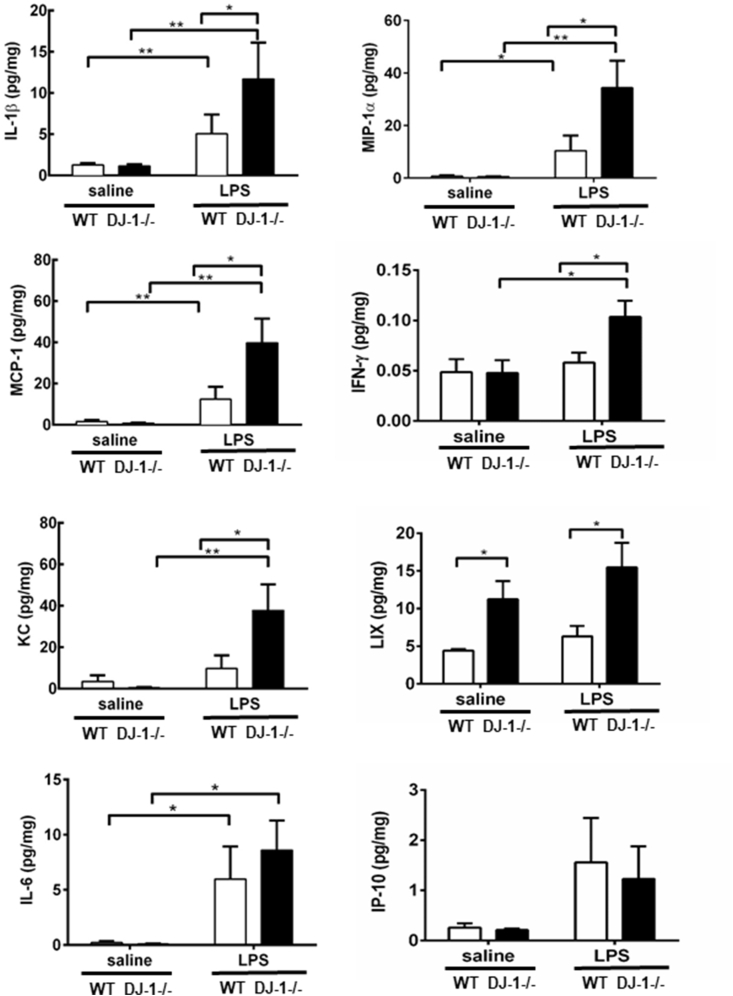
DJ-1 deficiency enhances lung inflammation following LPS instillation. Levels of inflammatory mediators in lung homogenates and serum from WT or DJ-1−/− mice 24 post LPS instillation. Mediators profiled: interleukin-1 beta (IL-1β), macrophage inflammatory protein 1 alpha (MIP-1α/CCL3), monocyte chemoattractant protein-1 (MCP-1/CCL2), interferon gamma (IFN-γ), keratinocyte chemoattractant (KC/CXCL1), LIX(CXCL5), interleukin-6 (IL-6) and interferon gamma-induced protein 10 (IP-10/CXCL10. Data are presented as means ± SEM (n = 6–8 per group, *p < 0.05, **p < 0.01, two-way ANOVA).